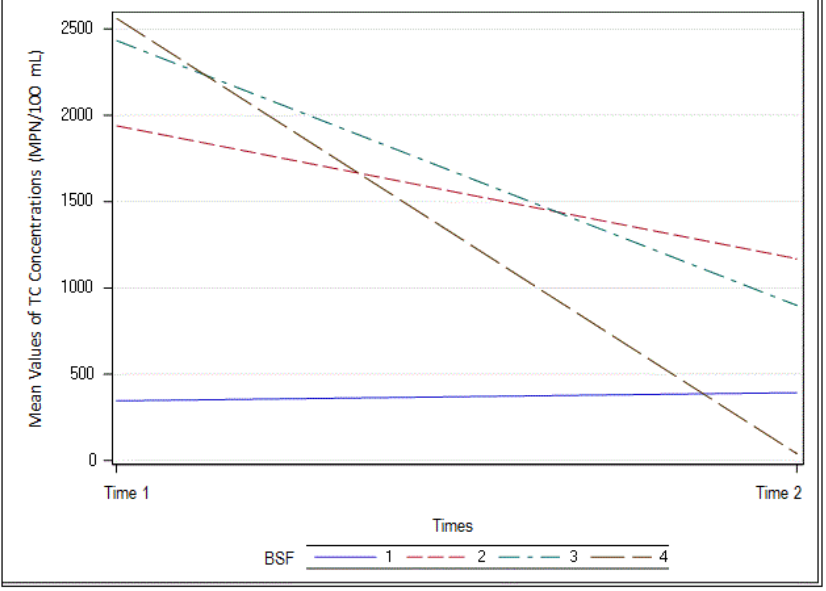
Figure 8. Analysis of variance for repeated measures by mixed models of total coliforms (TC).